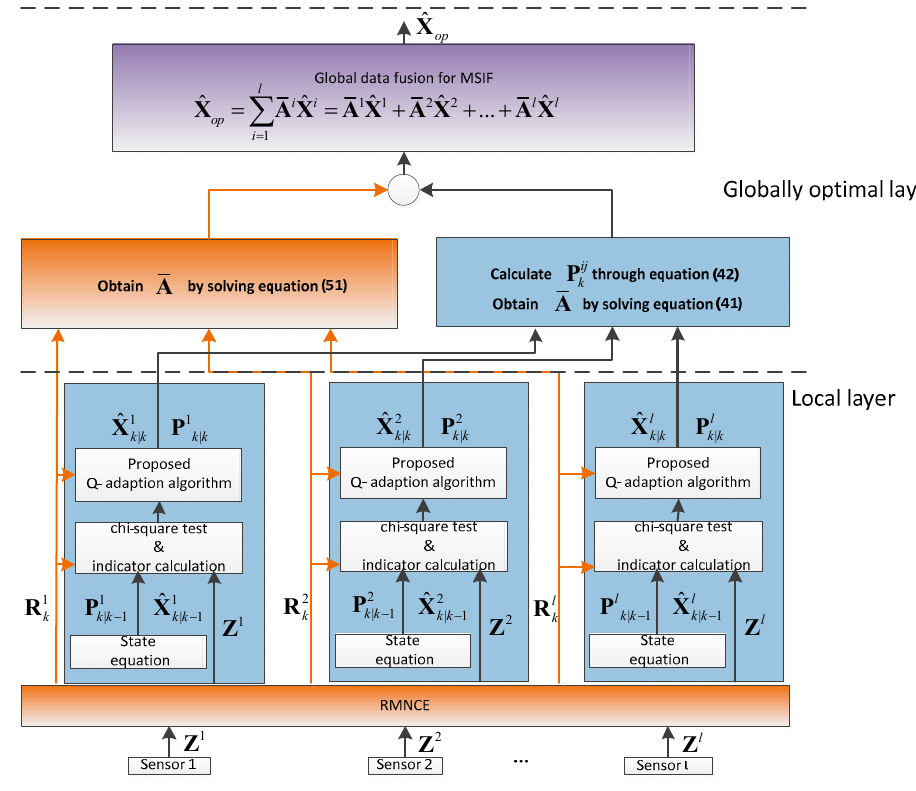
Figure 1. The framework of the proposed ARUKF ‐ MSIF